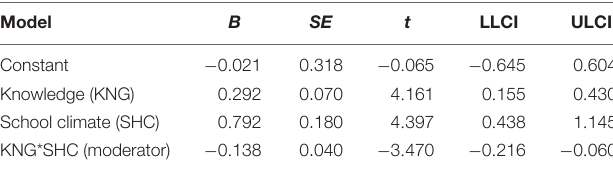
TABLE 3 | Interaction of school climate between COVID-19 knowledge and anxiety